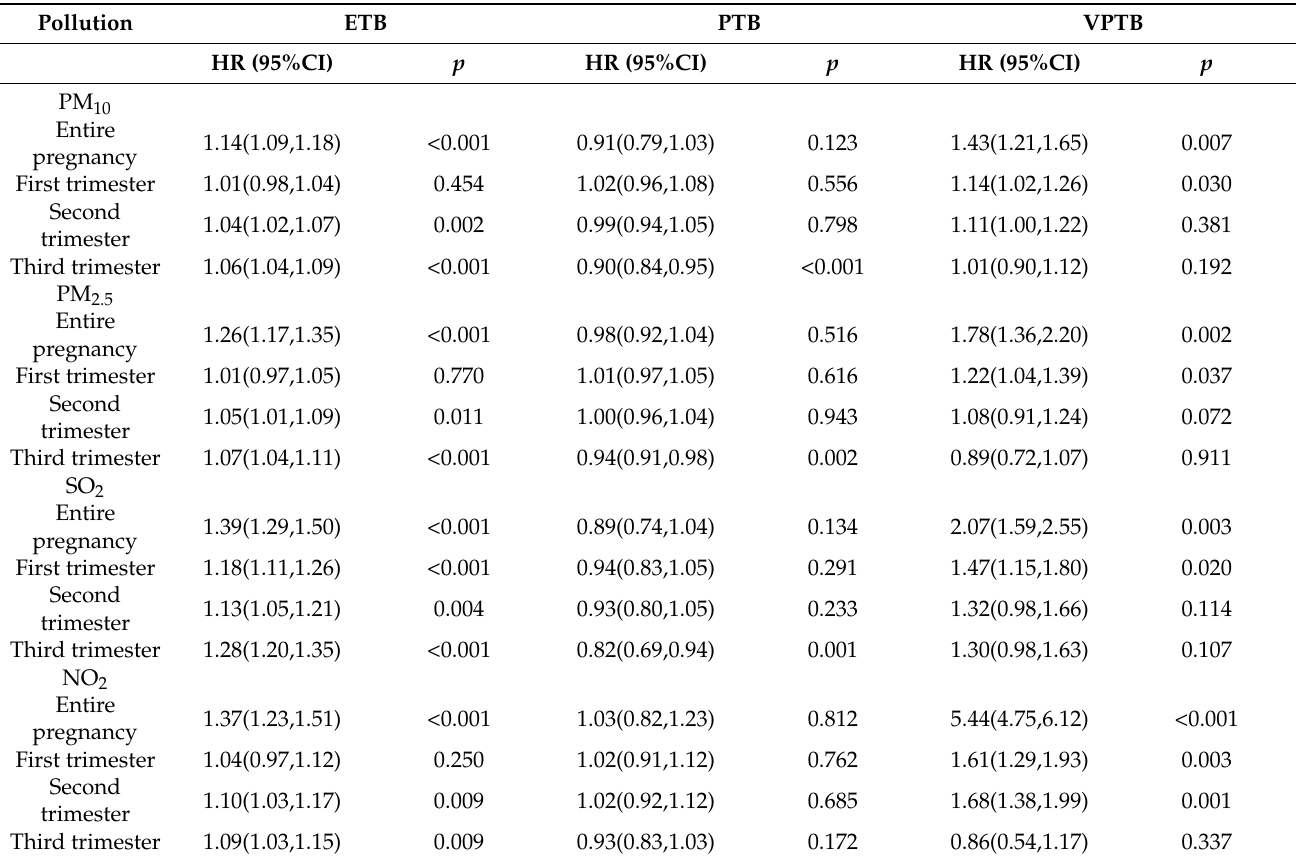
Table 2. HRs and 95% CIs of ETB, PTB, and VPTB for 10- µ g/m 3 increases of each pollutant in different trimesters.